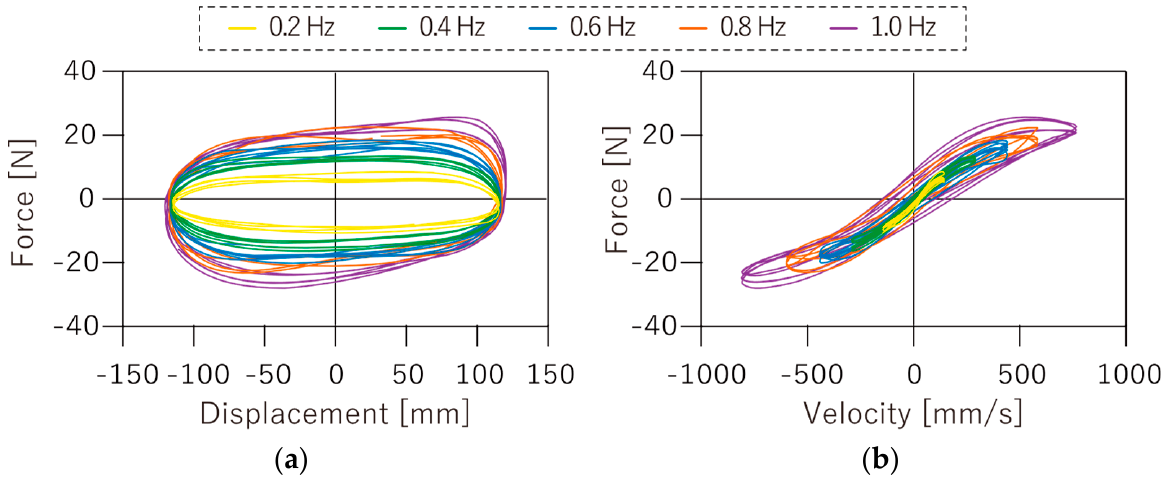
Figure 10. Hysteresis loop of viscous damper measured under sin wave excitation test at different frequencies: ( a ) Force–displacement loops; ( b ) force–velocity loops.